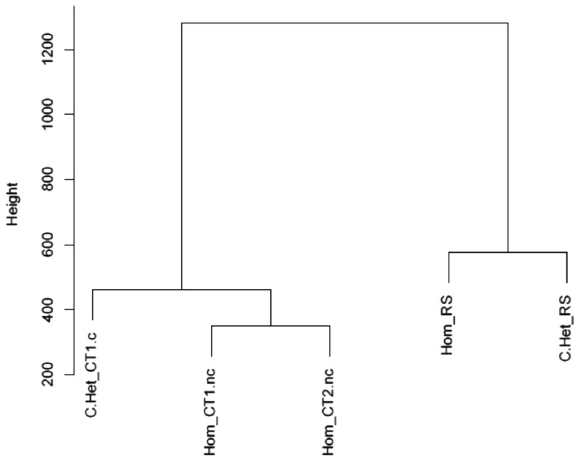
Fig. 7 Cluster analysis for minor intron retention of affected subjects vs. controls. Cluster analysis was performed using the euclidean distance metrics. A clear discrimination of minor intron retention levels is demonstrated between affected subjects of both heterozygous and homozygous mutations, and their unaffected controls. C.Het_CT1.c-Unaffected carrier mother of patient 2; Hom_CT1.nc-unaffected, non-carrier male sibling of patient 1, aged 3 months; Hom_CT2.nc-unaffected, non-carrier male sibling of patient 1, aged 9 years; Hom_RS-Patient 1; C.Het_RS-Patient